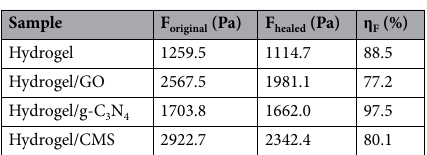
Table 1. F and self-healing parameter of the samples.